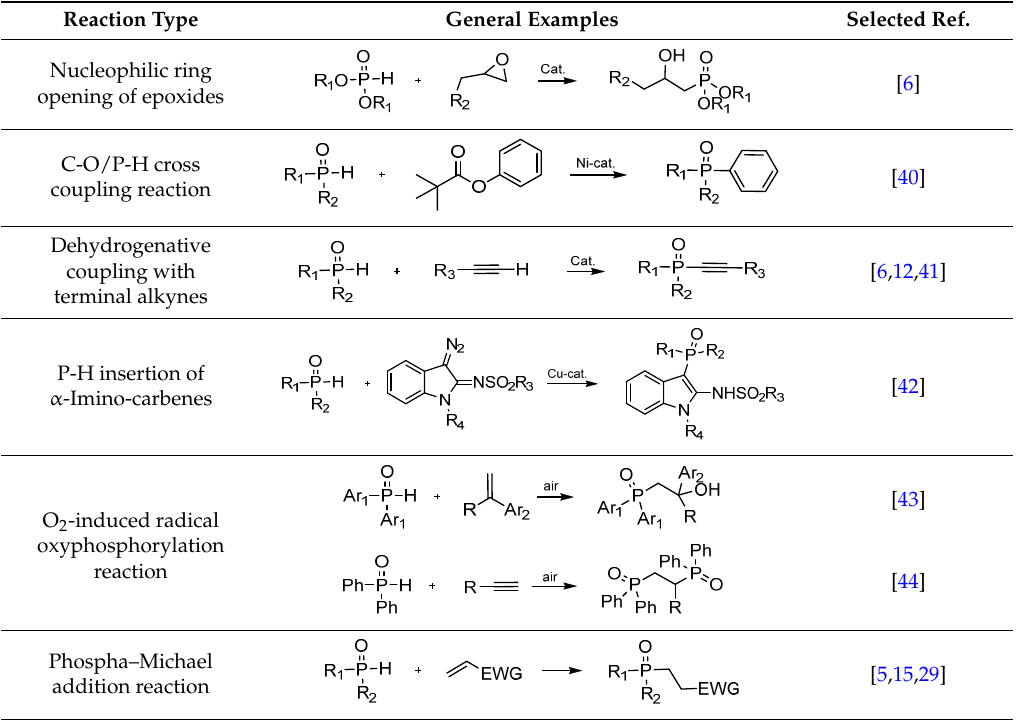
Table 2. Rearrangement/transformation Reactions. General Examples Selected Ref.